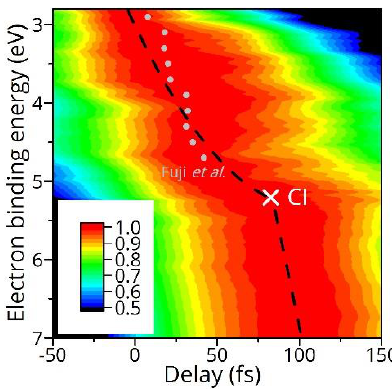
Figure 4. Normalized time-resolved photoelectron spectroscopy (TRPES) spectra of furan.